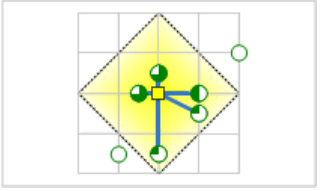
Figure 1. Display of point selection in the MA-model.